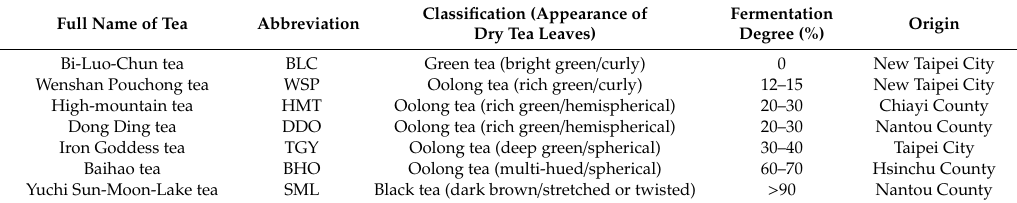
Table 1. The seven representative Taiwanese teas used in this research